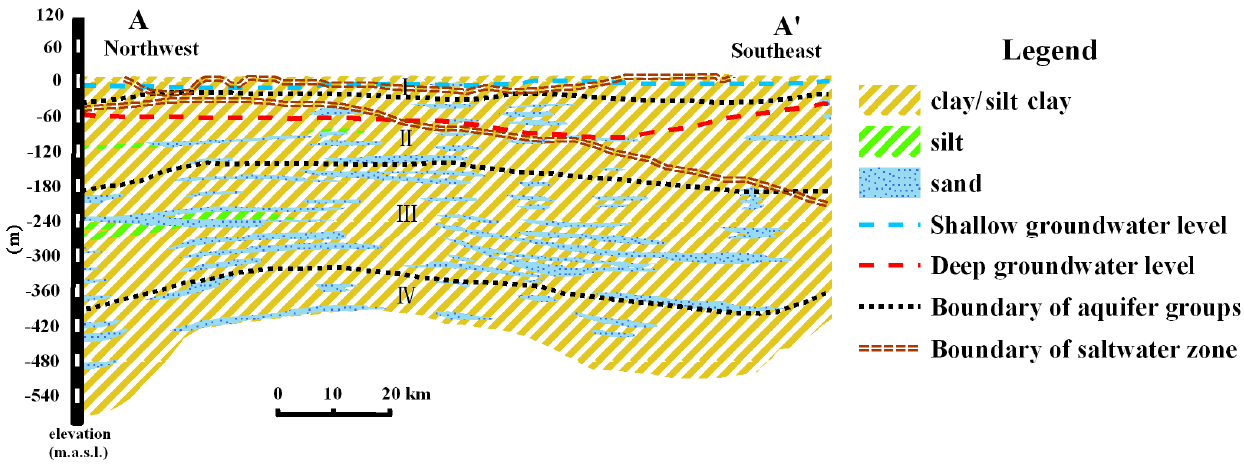
Figure 2. Lithology and aquifer division of transect A–A' in Cangzhou (modified from Zhang et al. [35]).